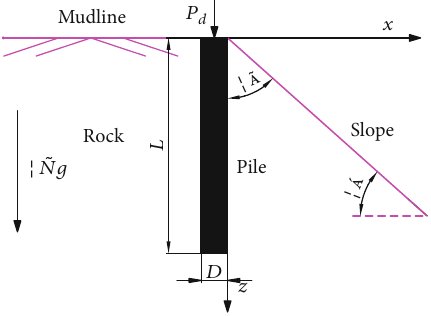
Figure 1: Schematic view of the slope-pile